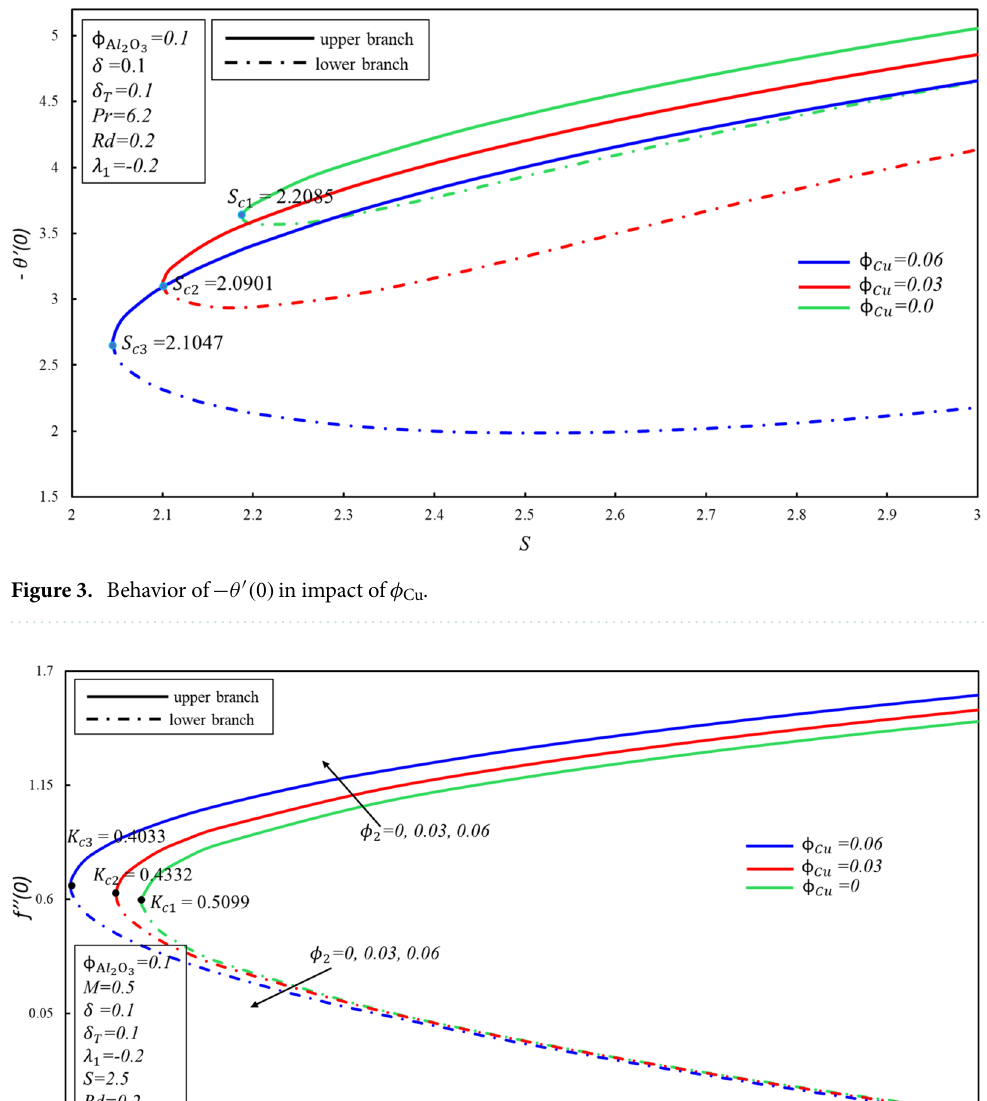
Figure 4. Behavior of f ′′ ( 0 ) in impact of φ Cu